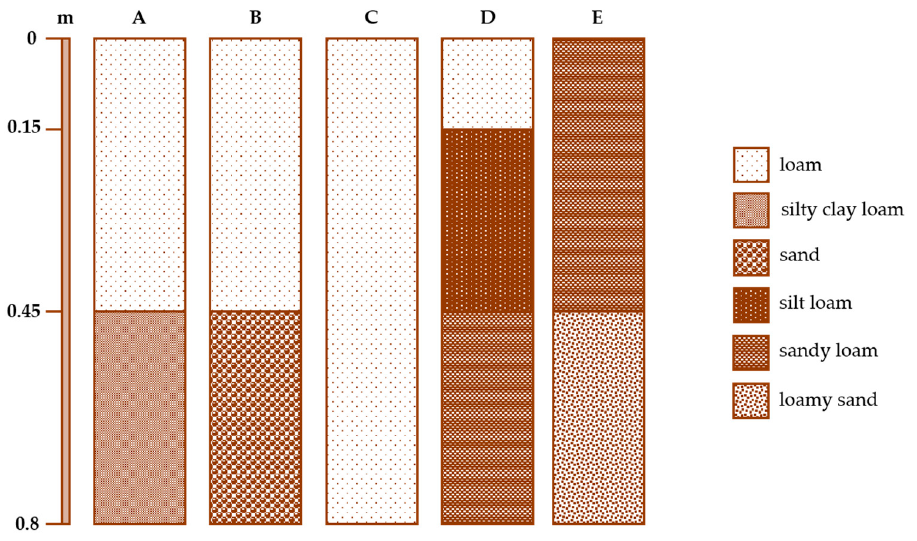
Figure 3. Soil profile (USDA texture classes) found at the monitoring stations ( A , B , C , D , E ). Table 3. Soil texture (weight percentage; sand > 50 µm, silt 50–2 µm, clay < 2 µm), pH1:2 (i.e., measured on a 1:2 soil water extract), electrical conductivity (EC1:2, dS m − 1 ), soil organic carbon (SOC,